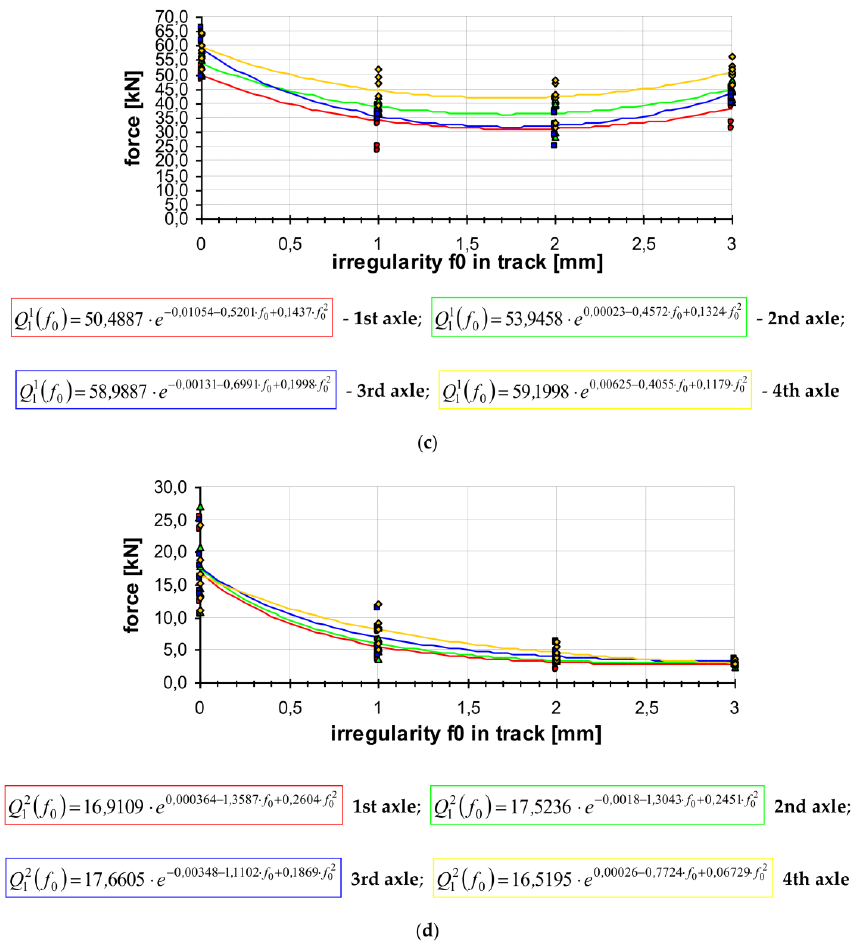
Figure 12. A dependence on the force transferred from the rail to the railway sleeper on the f 0 value of irregularity induced in the railway track (the loads from the locomotive’s succeeding axles; the scheme from Figure 3—the site surveys): ( a ) the change of the force in section no. 2 from a force in section no. 2 (the succeeding axles); ( b ) the change of the force in section no. 1 from a force in section no. 2 (the succeeding axles); ( c ) the change of the force in section no. 1 from a force in section no. 1 (the succeeding axles); ( d ) the change of the force in section no. 2 from a force in section no. 1 (the succeeding